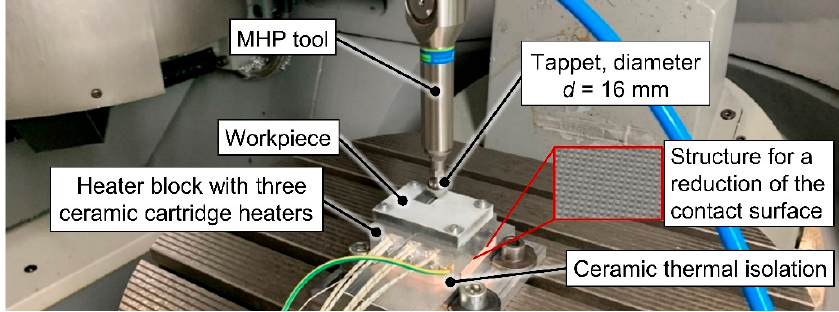
Figure 2. Device and experimental setup for thermally assisted Machine Hammer Peening.